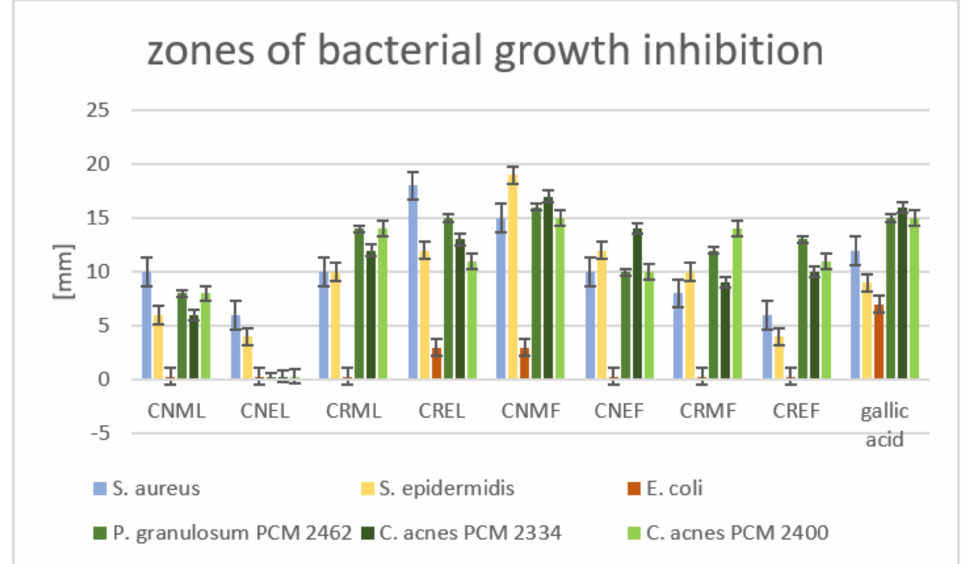
Figure 5. Zones of bacterial growth inhibition caused by extracts obtained from the fruits or leaves of C. roseus and C. nebrodensis . CNML—methanol–acetone–water (3:1:1, v / v ) extract of the leaves of C. nebrodensis ; CNEL—60% ethanol extract of the leaves of C. nebrodensis ; CRML—methanol– acetone–water (3:1:1, v / v ) extract of the leaves of C. roseus ; CREL—60% ethanol extract of the leaves of